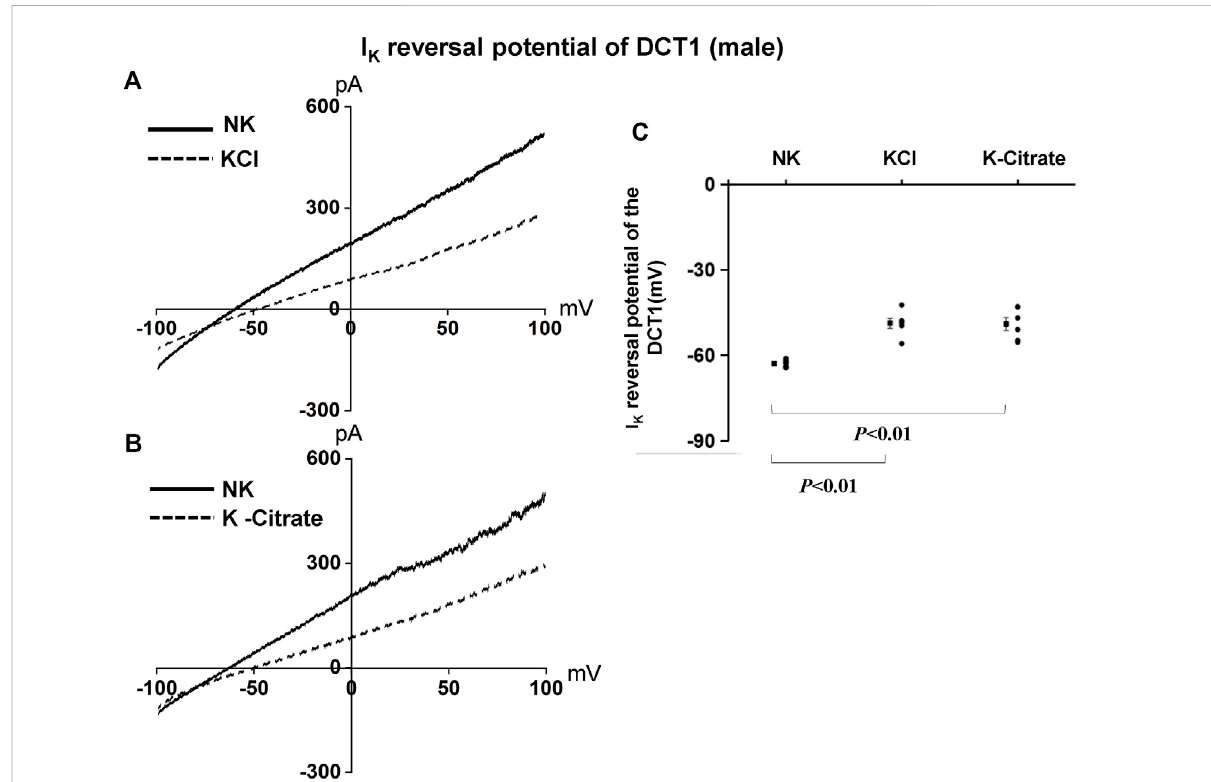
FIGURE 3 HK similarly depolarizes the basolateral membrane of the DCT in male mice regardless Cl − content. A set of whole-cell recordings shows I K reversalpotentialintheDCTofmalemiceonNKor5%K-Cldietfor7 days (A) andonNKor5%K-citratedietfor7 days (B) .ForthemeasurementofI K reversal potential, the bath solution contained 140 mM NaCl and 5 mM KCl, and the pipette solution contained 140 mM KCl. (C) A scatter graph summarizes the results of experiments in which I K reversal potentials were measured in the DCT of male mice on different K + diets. The mean value and SEM are shown on the left of each